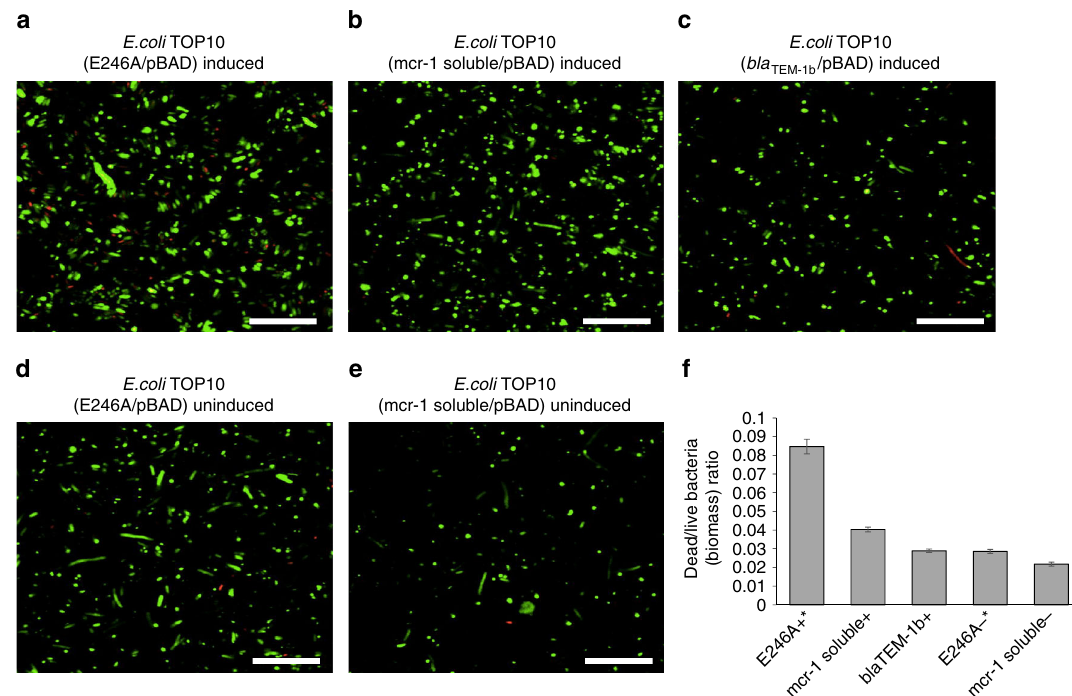
Fig. 5 The toxic effects of mcr-1 mutants on cell viability. a – c Confocal laser scanning microscopy images of cells treated with L -arabinose (0.2% w/v; 8 h) and stained with LIVE/DEAD ® ( n = 4). Live and dead cells presented in green and red colour, respectively. d and e Confocal laser scanning microscopy images of control cells treated without L -arabinose for 8 h and stained with LIVE/DEAD ® ( n = 4). Live and dead cells presented in green and red colour, respectively. f Ratio of dead to live bacteria (biomass) obtained from CLSM z -stack images through COMSTAT analysis ( n = 4). The COMSTAT data was assessed using one-way analysis of variance (ANOVA) followed by Tukey – Kramer multiple comparisons post hoc test, '+' and ' − ' indicate bacteria treated with or without L -arabinose,